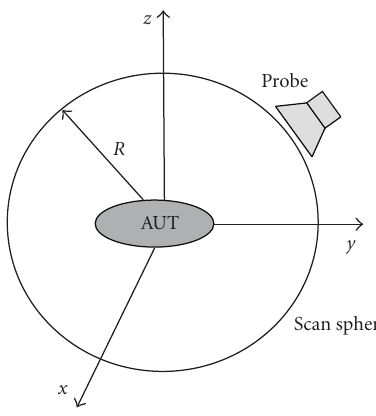
Figure 1: A probe with its reference point on the scan sphere of radius R and its normal pointing towards the origin measures the field of the